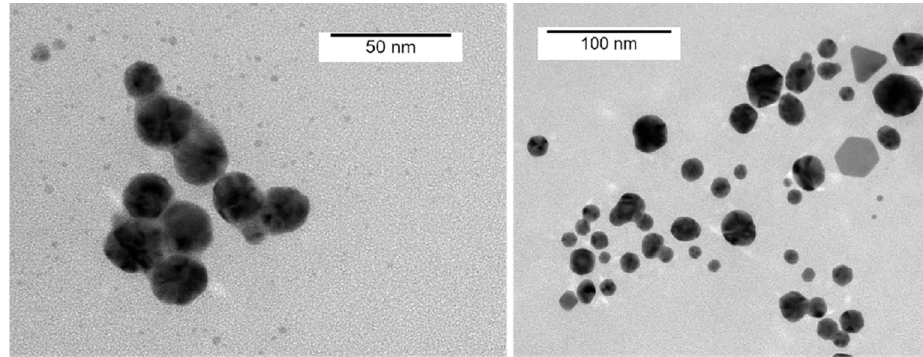
Figure 3. TEM images of the GL-reduced AgNPs at different scales.